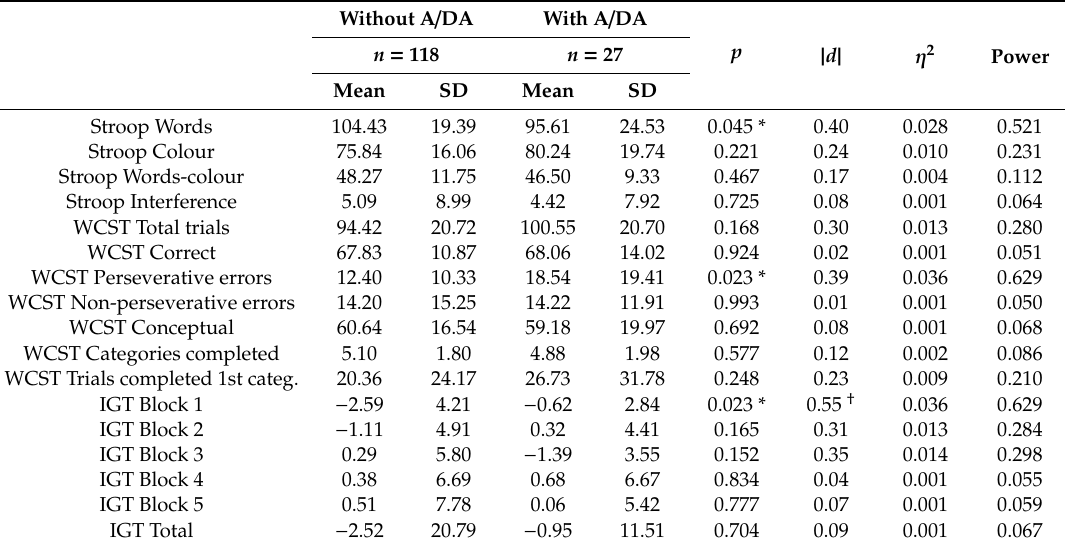
Table 4. Comparison of the neuropsychological profile between groups with and without A / DA. Without A / DA With A / DA